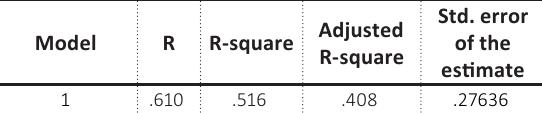
Table 3. Rotated component matrix